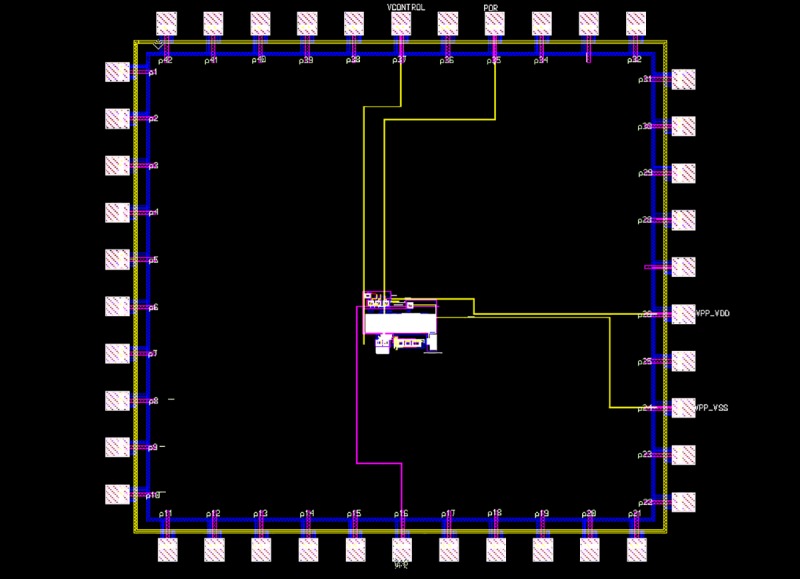
Chip layout of the proposed HVG with input/output pads.